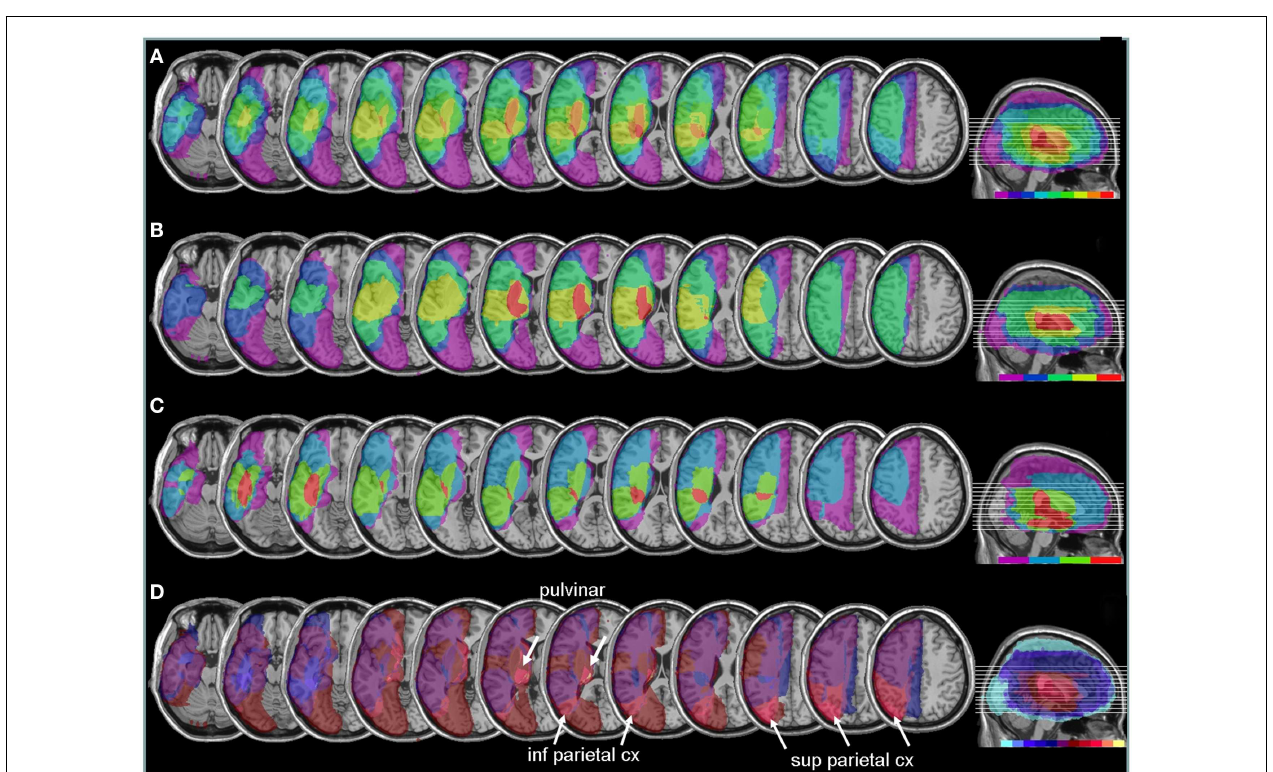
deficits at baseline, showing predominant damage in the temporal lobe and deep paraventricular white-matter. Colors code for the number of patients with damage to a given area (from 1 = violet to 5 = red). (D) Median split subtraction analysis, comparing the lesion in patients with severe vs. moderate neglect at baseline. Each color in the scale bar codes for a 16.67% frequency of lesion in one or the other group, except for the central purple color that represents − 16.67 to + 16.67%. More severe initial neglect correlated with more frequent damage to posterior parietal cortex and pulvinar (purple to yellow shades), while less severe neglect correlated with temporal white-matter damage (blue to turquoise shades).